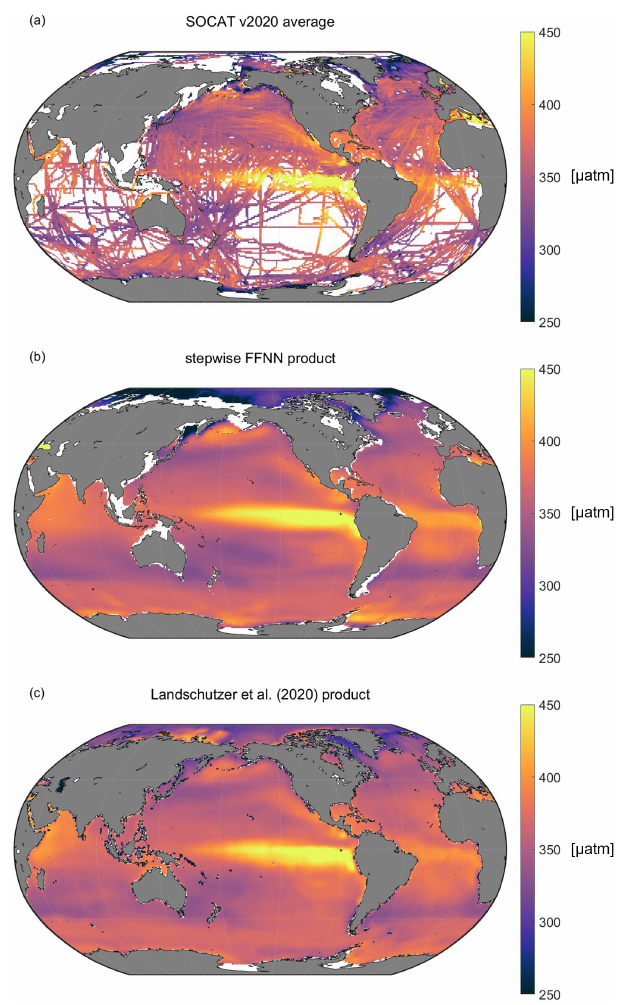
Figure 9. Comparison between the long-term average of (a) the SOCAT v2020 dataset, (b) the stepwise FFNN p CO 2 product, and (c) previous climatology product adapted from Landschützer et al.